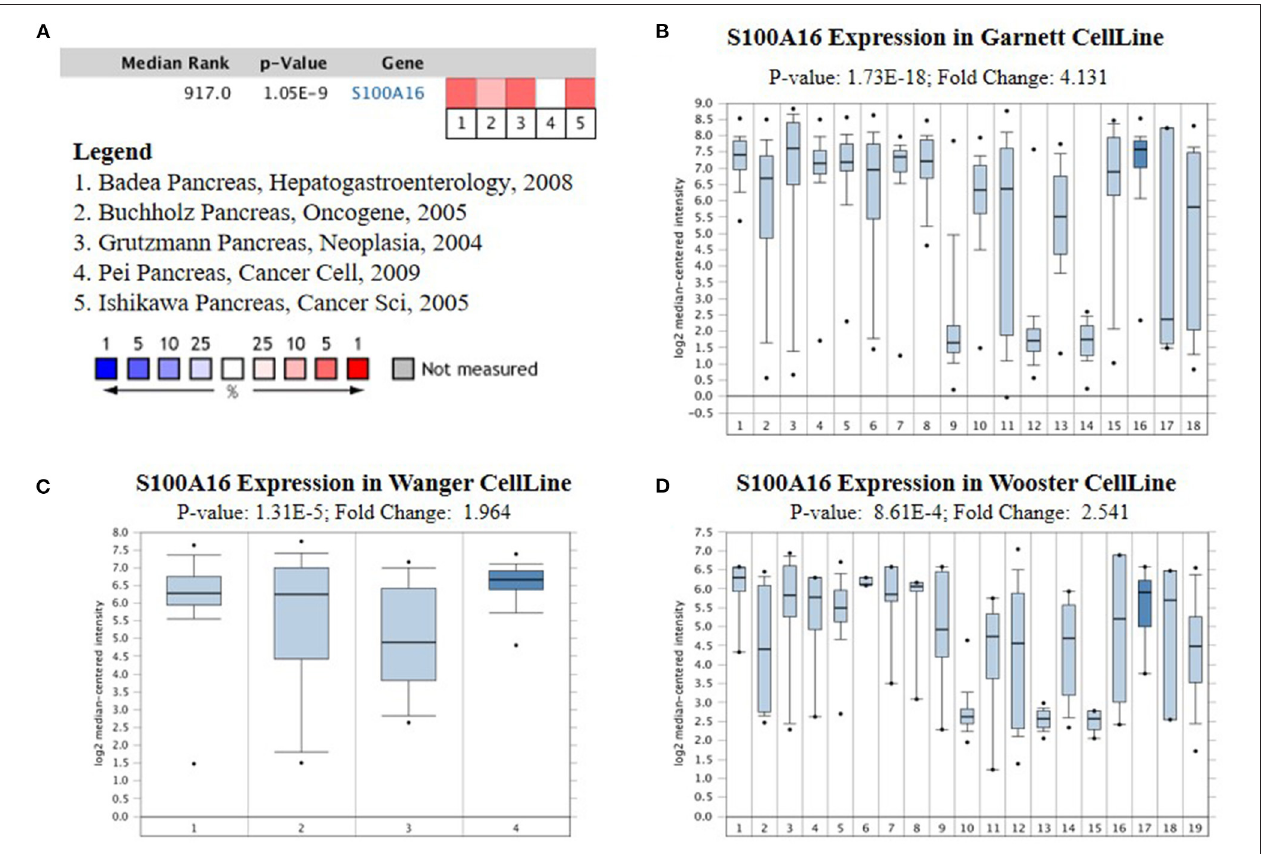
FIGURE 4 | Analysis of relationship between the S100A16 expression and the type of PC. (A) Comparison of S100A16 expression across five analyses, and red means high expression. S100A16 expression in (B) Garnett cell Line , (C) Wanger cell line (D) Wooster cell line. The expression level is evaluated via the median line; Top 10% refers to the top 10% of genes; P < 0.01.